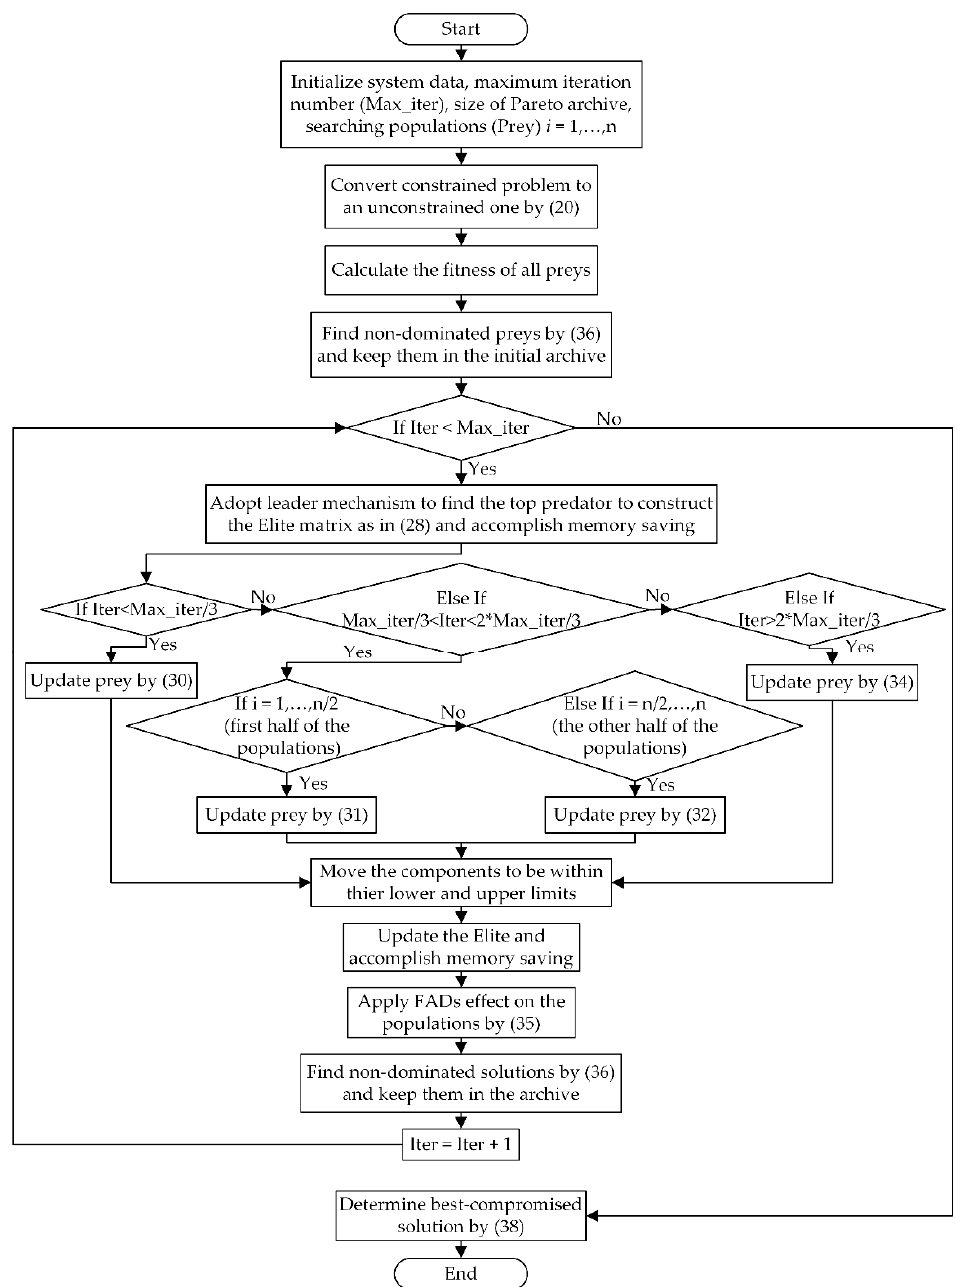
Figure 1. Flowchart of the many-objective marine predators’ algorithm (MaMPA).